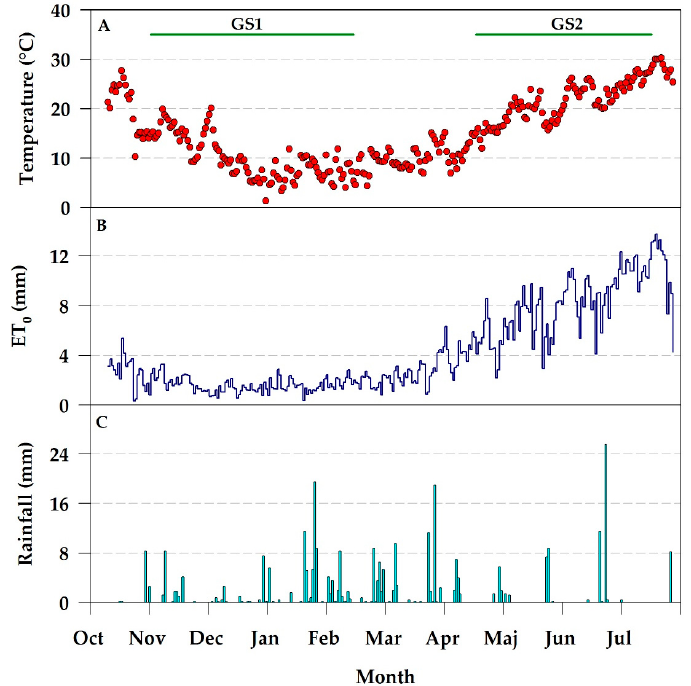
Figure 3. Daily average of air temperature ( A ), reference crop evapotranspiration ( B ) and precipitation ( C ), registered during the two crop growing seasons of lettuce–radicchio (GS1) and zucchini